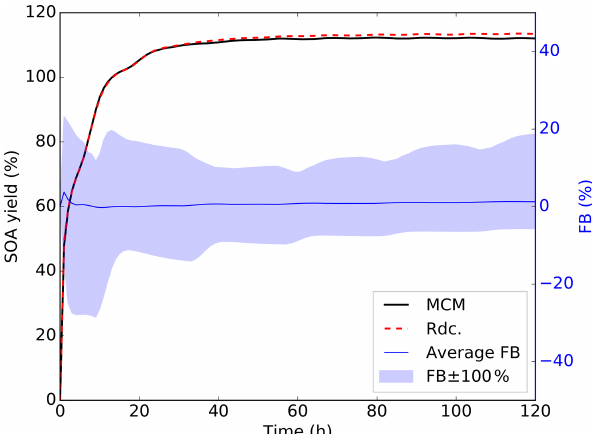
Figure 8. Temporal variation in the total SOA concentration simu- lated with the pre-testing dataset using the MCM (red dashed line) and Rdc. (solid black line) mechanisms under nonideal conditions. The average (solid blue line) and maximum (blue shading) FB val- ues between the MCM and the Rdc. mechanisms are also presented. Table 8. Average SOA concentrations per volatility class simulated with the MCM and the Rdc. mechanisms on the pre-testing dataset at 8 and 72h (in µgm − 3